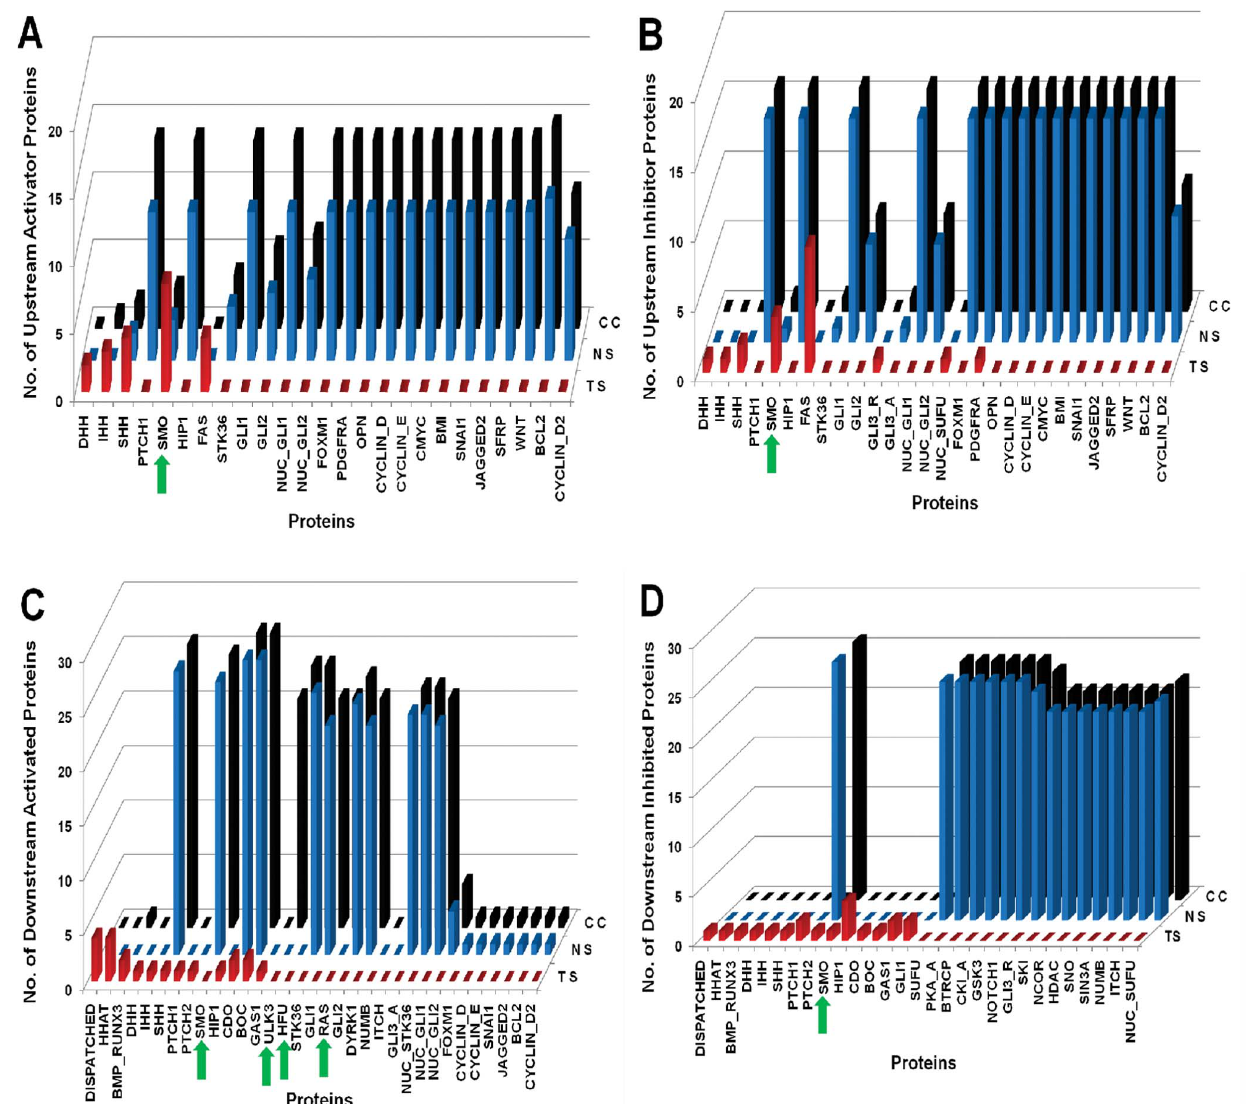
Figure 5. Comparison between Normal, Cancer and Perturbed scenarios for Colon Cancer. TS: Treated Scenario; NS: Normal Scenario; CC: Colon Cancer Scenario. The green arrow heads are indicating the minimal combination of proteins which was inhibited in the drug treated perturbation analysis. (A) Represents number of Upstream activator proteins (Y-axis) activating the proteins (X-axis) representing significant variations. Compared to the normal scenario, proteins, SHH, IHH, SMO, GLI1, GLI2 and output proteins BMI, SNAI1, BCL2 and Cyclins are activated by maximum number of upstream activator proteins. On drug treated perturbation of SMO, HFU, ULK3 and RAS, the number of activators of the output proteins become zero. (B) Represents number of upstream inhibitory proteins (Y-axis) inhibiting the proteins (X-axis) representing significant variations. The numbers of upstream inhibitor proteins in normal versus Colon cancer scenario remain same. Similar perturbation results are observed as in (A). (C) Represents number of downstream proteins (Y-axis) activated by the proteins (X-axis) representing significant variations. The number of downstream proteins activated in normal versus Colon cancer scenario remains same. On perturbation of SMO, HFU, ULK3 and RAS, the number of downstream proteins activated by these proteins is reduced to zero. (D) Represents number of downstream proteins (Y-axis) inhibited by the proteins (X-axis) representing significant variations. The numbers of downstream proteins inhibited in normal versus Colon cancer scenario remain same.